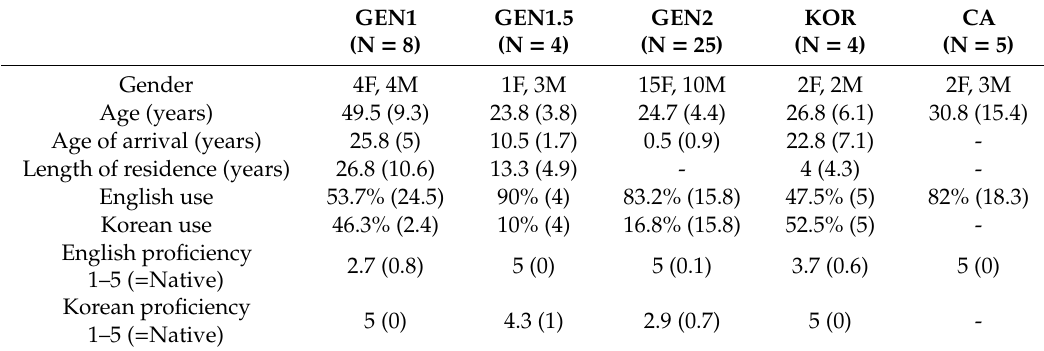
Table 1. Participants’ language backgrounds (standard deviation is presented in